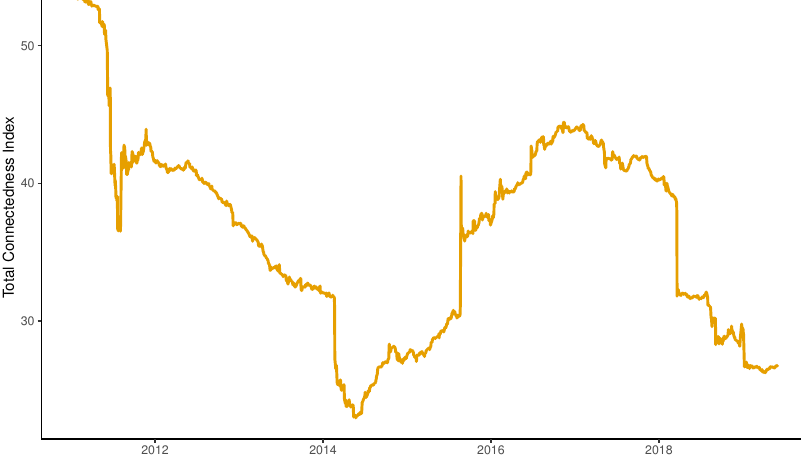
Figure 2. The total connectedness index ( C H ), indicating total connectedness among the stock t volatilities for the time period from June 2008 to June 2019. A two-year rolling estimation window is utilized and a 10-step-ahead predictive horizon is used for the underlying variance